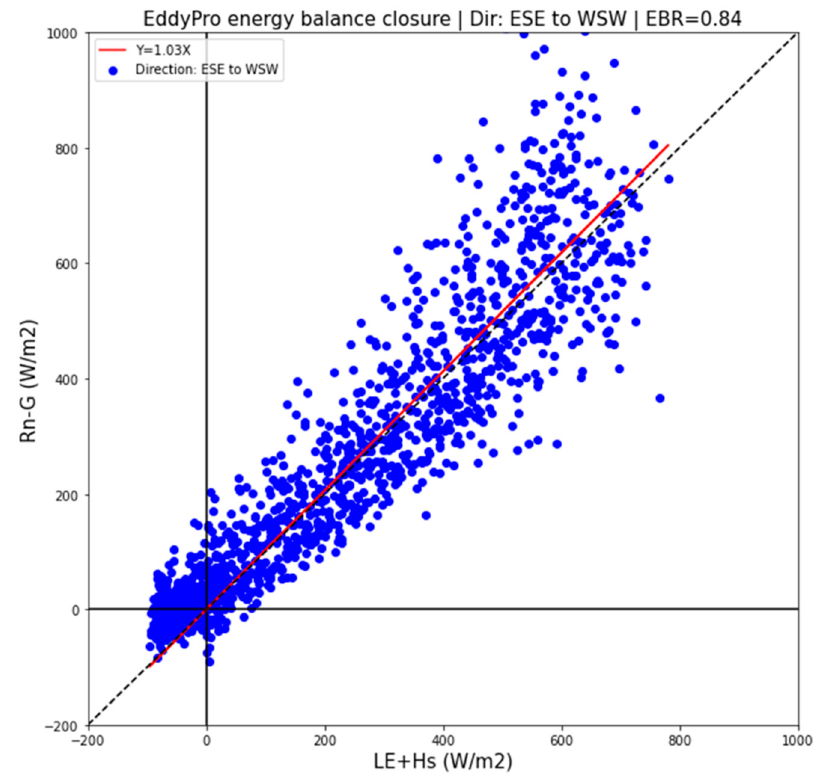
Figure 2. When wind directions are between 112.5 and 247.5 degrees (i.e., ESE to WSW), the heat fluxes (the sum of sensible and latent heat fluxes) accounted for a median of 90% of available energy, suggesting a good energy closure.